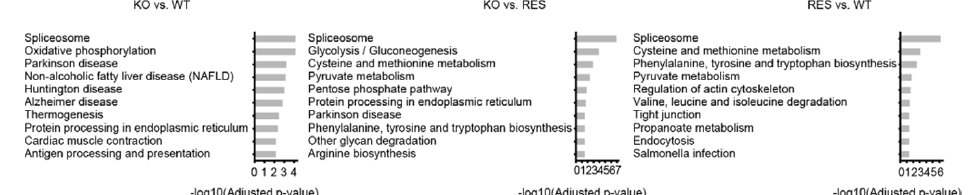
Figure A2. Gene ontology analysis of significantly regulated proteins. Bar charts representing the 10 top enriched terms of significantly regulated proteins in pairwise comparison of the groups (KO vs. WT, KO vs. RES and RES vs. WT).